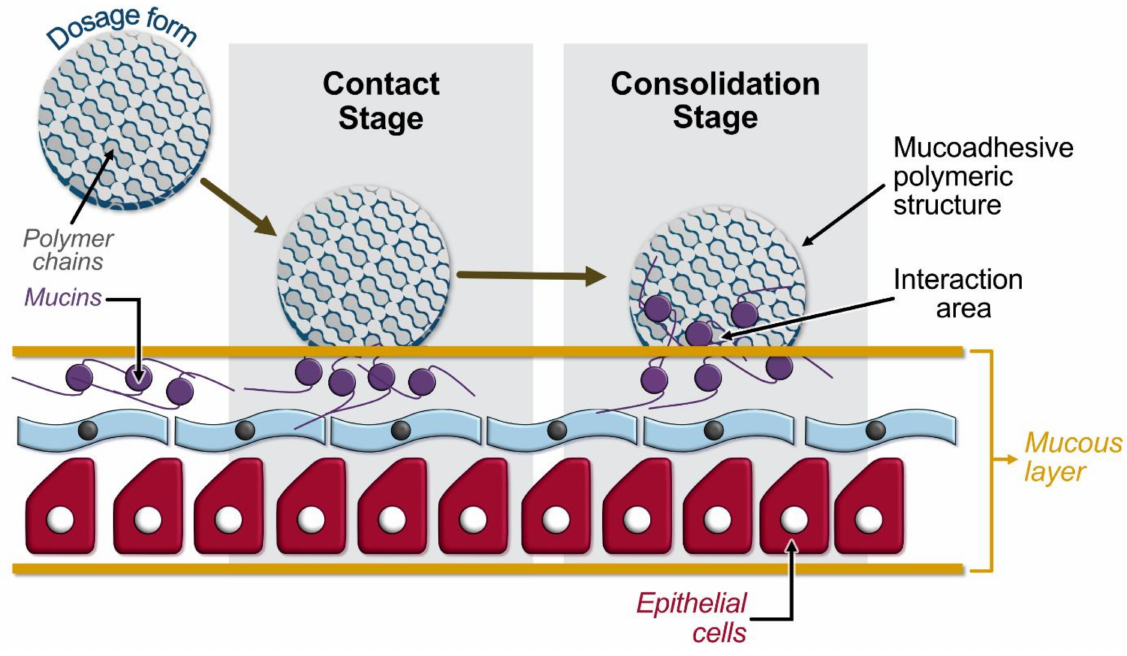
Figure 4. Illustration of the two-stage (contact and consolidation stage) mucoadhesion